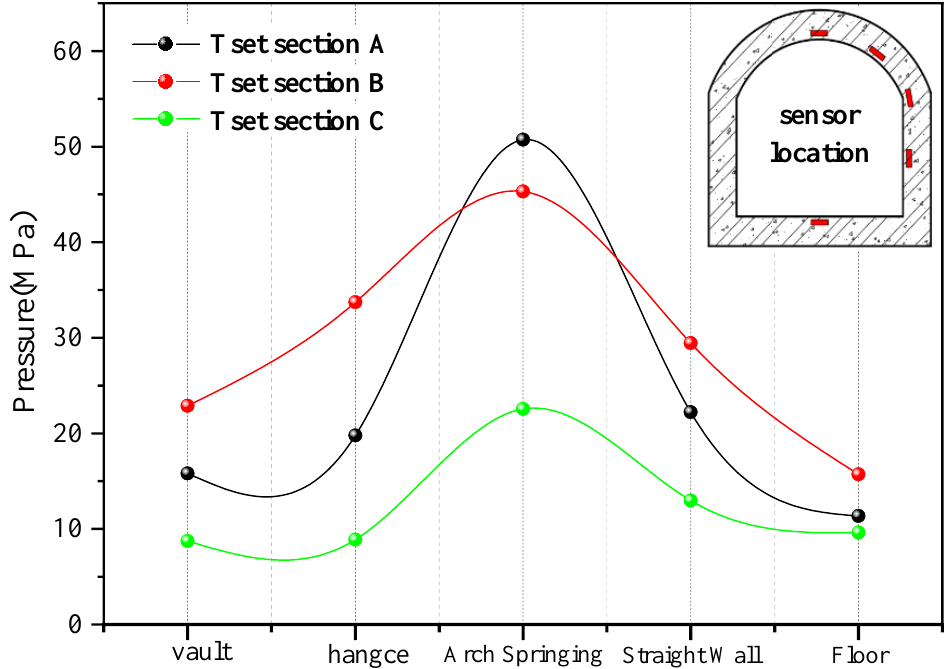
Figure 12. The peak stress tendency curve of the measured points in test sections.